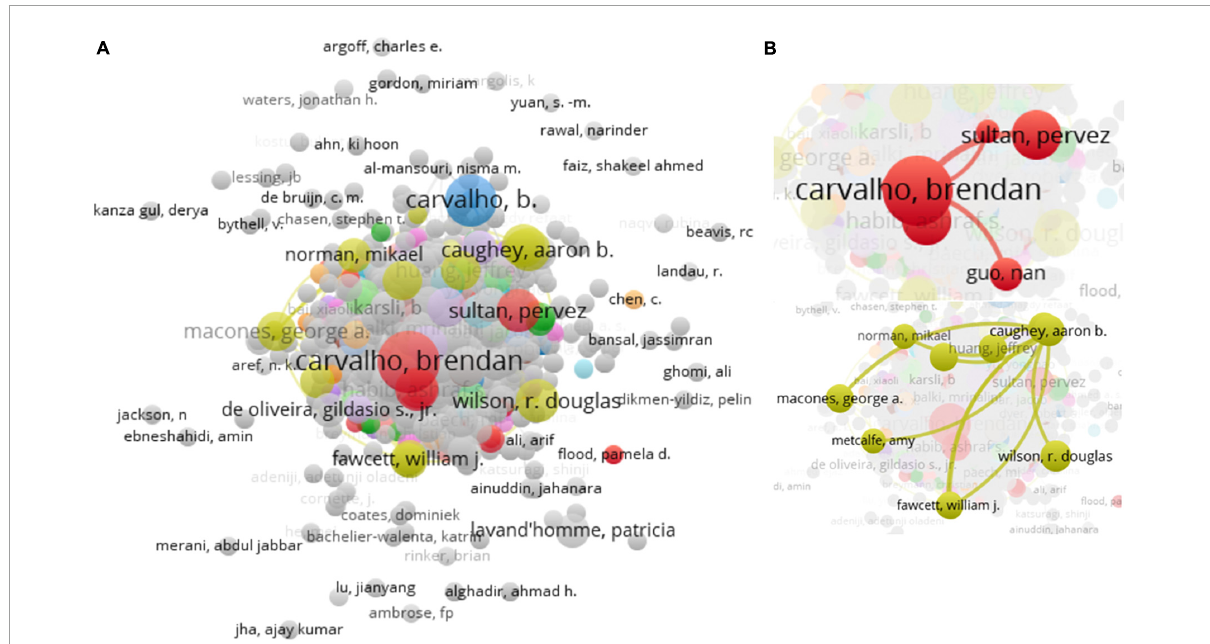
FIGURE3 Co-occurrence analysis of authors. (A) 4,934 items valid items were connected. (B) The cooperation of Brendan Carvalho and Aaron B. Caughey were